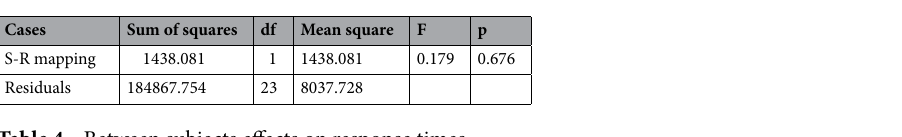
Table 4. Between subjects effects on response times.